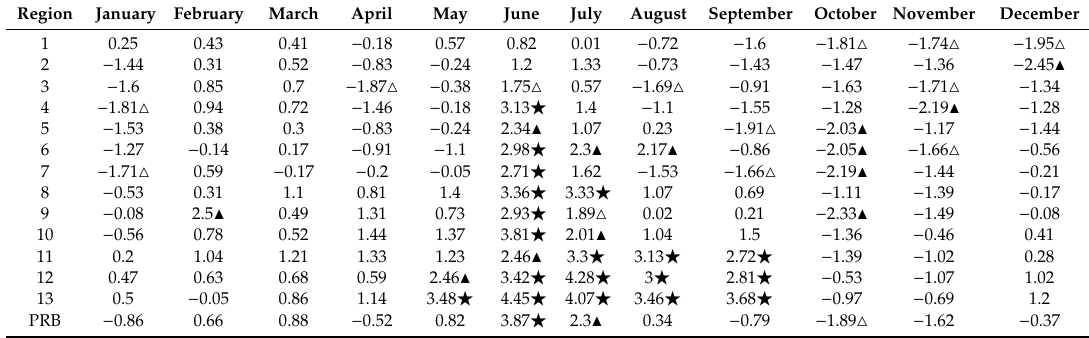
Table 2. M–K values for the ETa in the Pearl River Basin and its sub-regions at the monthly scale.